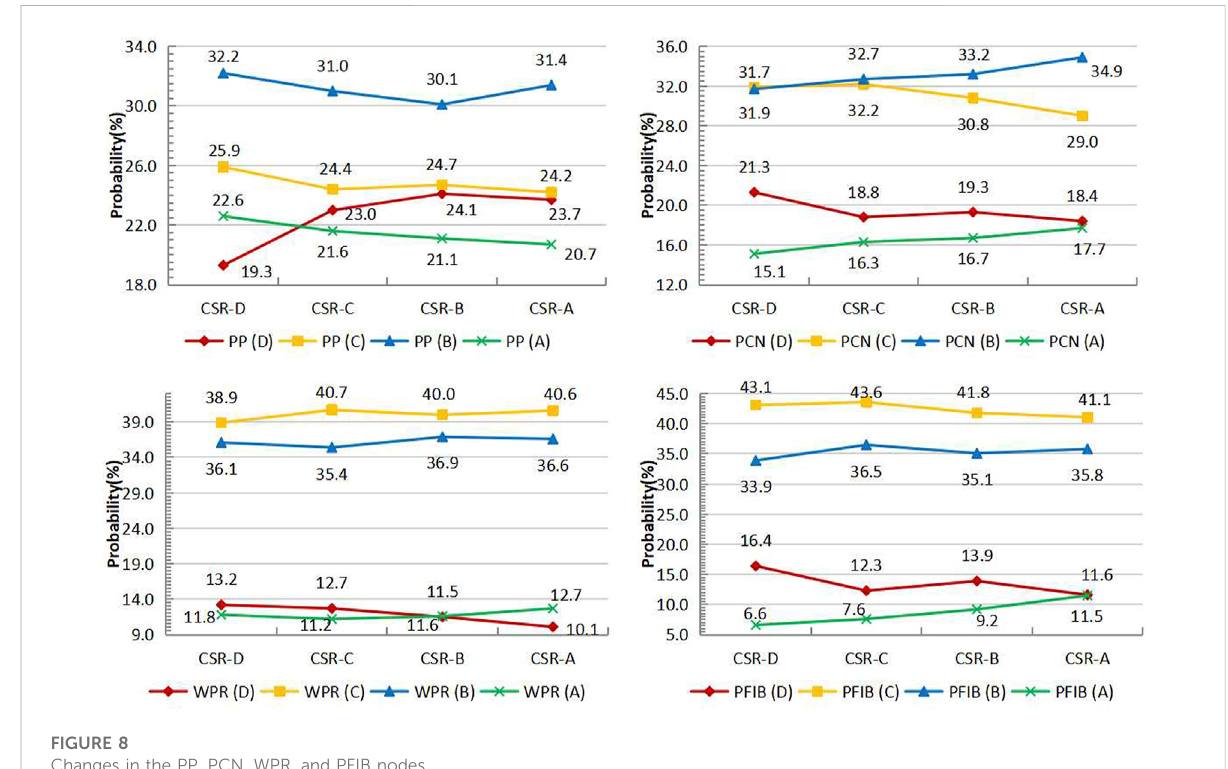
FIGURE 8 Changes in the PP, PCN, WPR, and PFIB